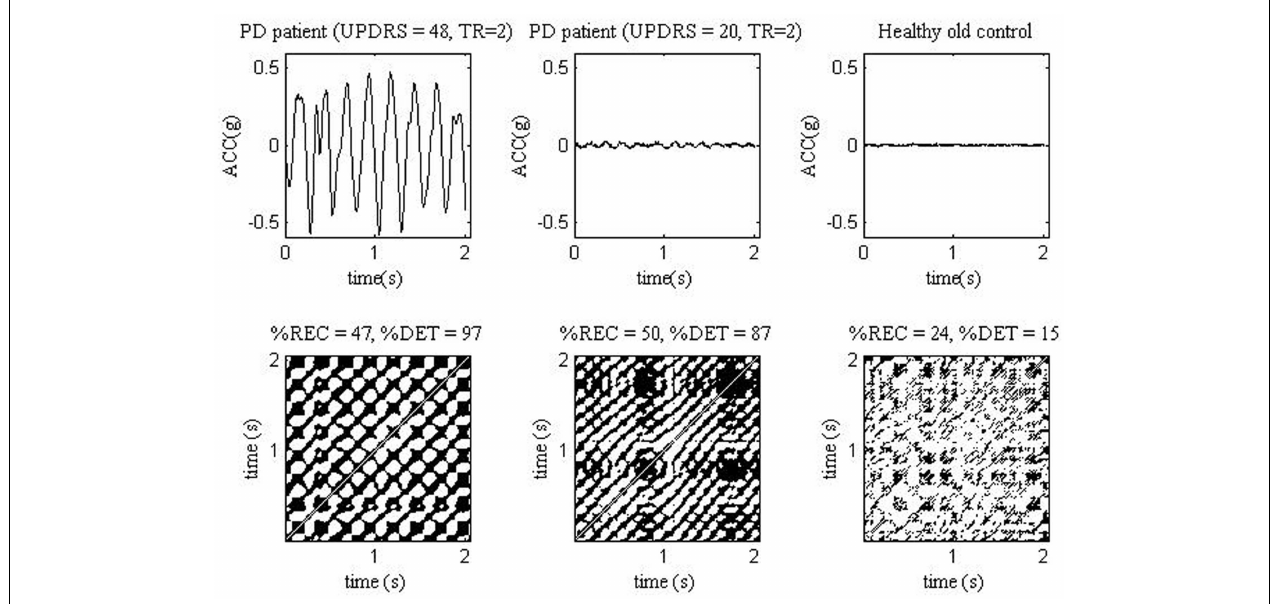
FIGURE 2 |ACC signals (top) measured from one PD patient with UPDRS = 48 and rest tremorTR = 2 (left), one PD patient with UPDRS = 20 and TR = 2 (middle) and one healthy old control (right) .The ACC measurements were analyzed in study (61).The corresponding ACC recurrence plots (bottom). TR, tremor